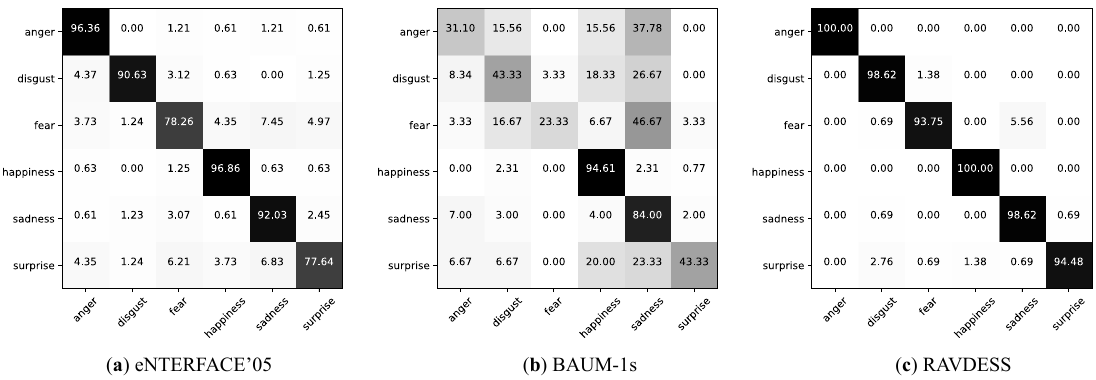
Figure 5. The confusion matrices of audio-visual emotion recognition using our method on the eNTERFACE’05, BAUM-1s, and RAVDESS datasets.